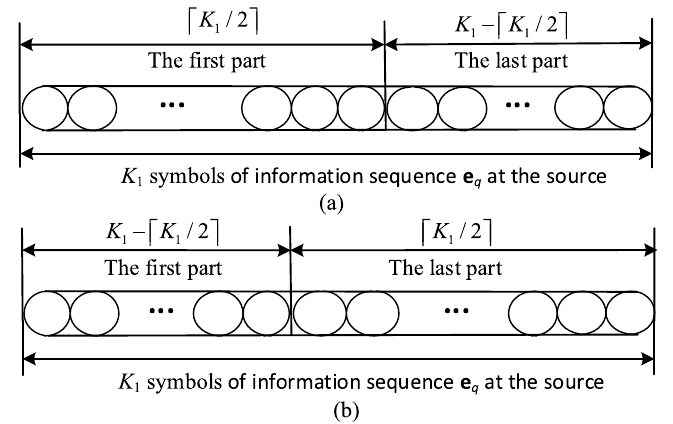
Fig. 3 Information sequence with more symbols in a first part, b last part. For information sequence with length K 1 at the source node, its symbols are divided into two cases. One case is the first part has more symbols, and the other case is the last part has more symbols. a denotes the symbol distribution diagram of information sequence with more symbols in the first part. b denotes the symbol distribution diagram of information sequence with more symbols in the last